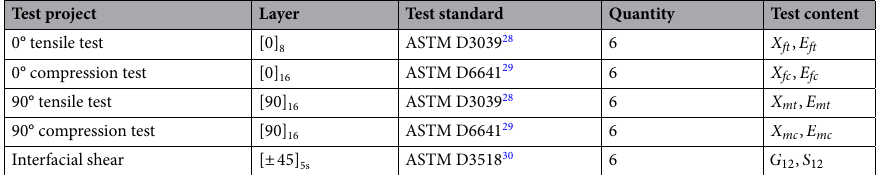
Table 1. Test matrix for basic mechanical properties of composite laminates. X ft , X fc , X mt , X mc , and S 12 are respectively longitudinal tensile strength, longitudinal compression strength, transverse tensile strength, transverse compression strength, and in-plane shear strength. E ft , E fc , E mt , E mc , and G 12 are respectively longitudinal tensile modulus, longitudinal compression modulus, transverse tensile modulus, transverse compression modulus, and in-plane shear